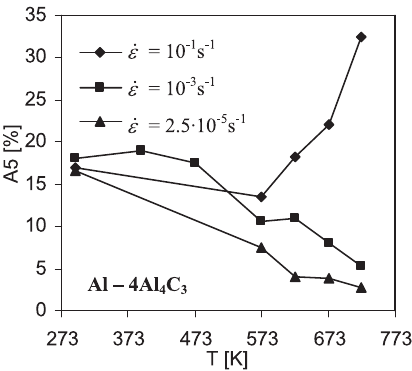
Fig. 12: Dependence of ductility on temperature and strain rate for Al-4Al C material 4 3